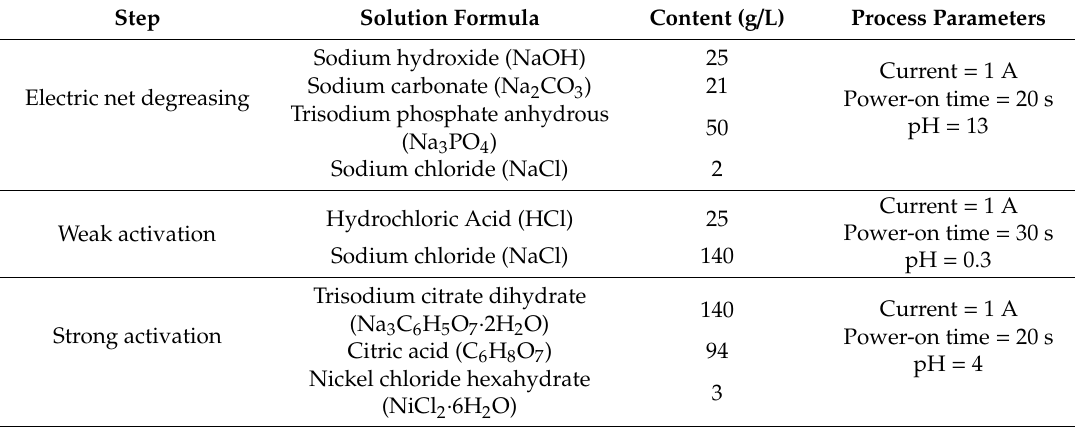
Table 3. The process of workpiece